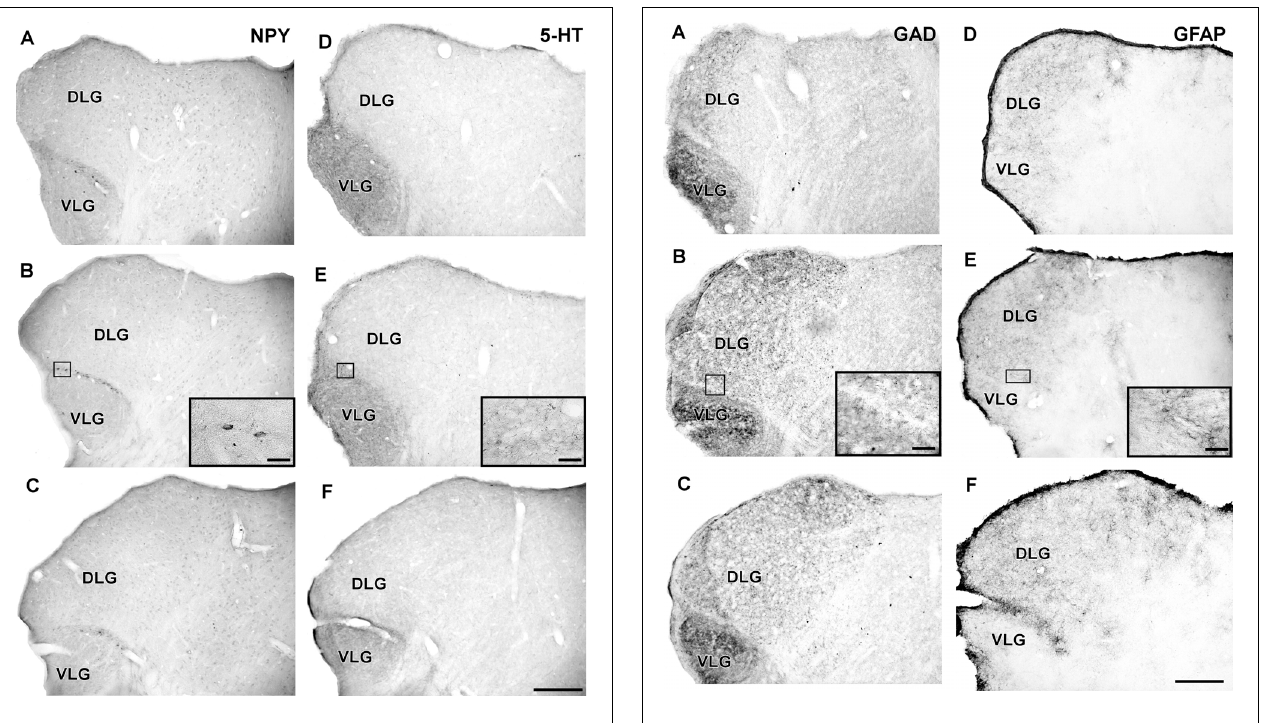
FIGURE 8 | Photomicrographs of the brain sections of flat-faced fruit-eating bat showing the IGL in bright field. (A–C) Immunoreactivity against NPY in the IGL at rostral, middle, and caudal levels, respectively. (D–F) Immunoreactivity against 5-HT in the IGL at rostral, middle, and caudal levels, respectively. The magnification of the boxed delimited area is shown in detail in the upper-right corner of each respective picture. DLG, dorsal lateral geniculate nucleus; VLG, ventral lateral geniculate nucleus. Scale bar 500 µ m.